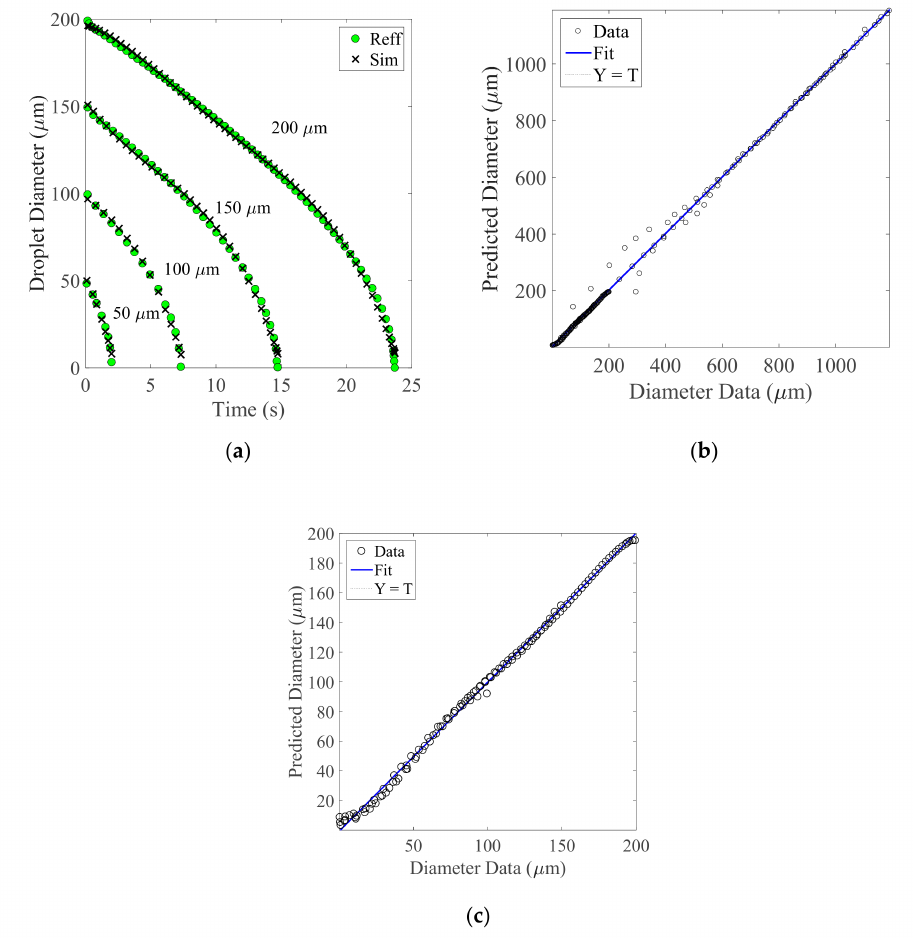
Figure 9. The droplet diameter reduction prediction compared to the reference data ( a ) as a function of time series, ( b ) the correlation between the predicted and reference data for all diameter data, and ( c ) for data with initial diameter less than 200 µ